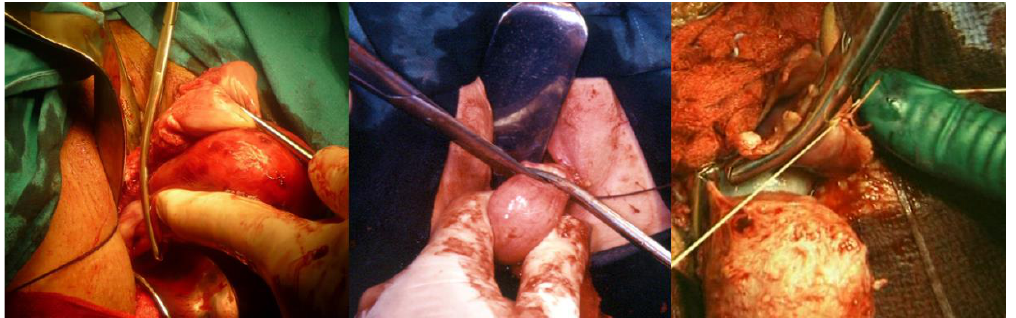
Figure 7. On the left, the Heaney clamp grasps the round and Utero-Ovarian ligaments and Fallopian Tubes; in the center, cutting the clamped tissues; on the right, ligation of the dissected tissues.